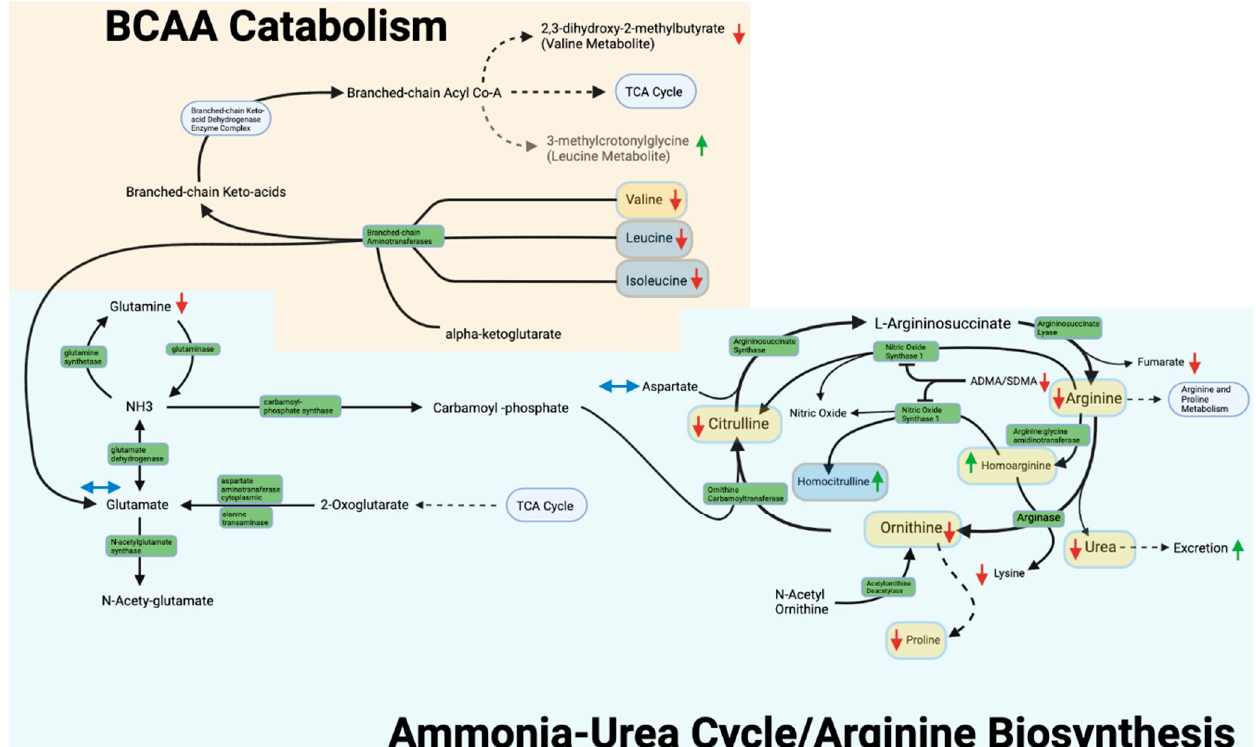
Figure 3. Arginine Biosynthesis, Ammonia-Urea Cycle and BCAA Catabolism. Enzymes are shown in green. Downward pointing arrows indicate lower metabolite peak areas during pregnancy (red), while upward arrows indicate higher peak area during pregnancy as compared to the non-pregnant postpartum control (green). Double pointed horizontal arrows indicate no change (blue). Metabolites that were subject to confirmatory quantitative analysis and confirmed to be significant are shown with rounded yellow translucent rectangles while those not significant in the confirmatory analysis are blue/gray. Asymmetric dimethylarginine and symmetric dimethylarginine are shown as ADMA/SDMA. Pathway structure was modeled using the Kyoto Encyclopedia of Genes and Genomes.